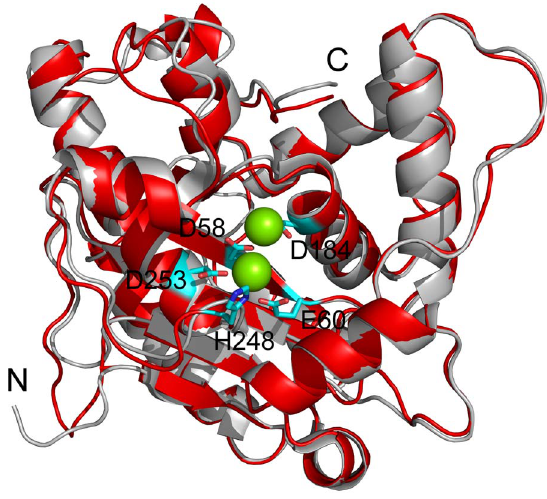
Figure 2. A comparison of the crystal structure of S.pombe Caf1p/Pop2p (gray, PDB ID: 2P51) and the predicted structure of CrCaf1 (red). The homology modeling of CrCaf1 structure was performed by SWISS-MODEL using the crystal structure of human Caf1a/CNOT7 (PDB ID: 2D5R) as the template structure. N and C are the N- and C-termini of the proteins. The positions of the four acidic residues and an additional His in the active site are highlighted by stick representation. The two Mg 2 + in the crystal structure of Caf1p are also presented by space-filling representation.